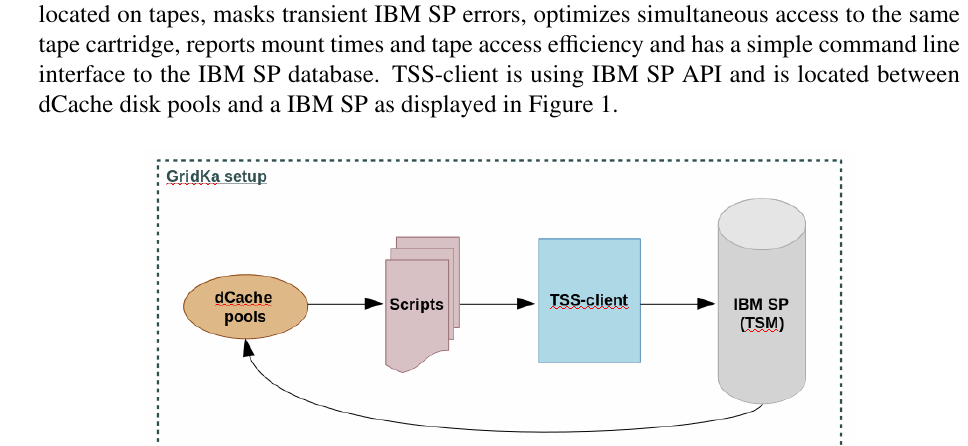
After the first recall test within ATLAS Distributed Computing (ADC) Tape Carousel in 2018, various local tests were performed on GridKa tape system. The main goal of these tests is a detailed study of the current tape setup, identifying and eliminating bottlenecks, properly adjusting and improving the current setup that will lead to increase of the overall tape storage system